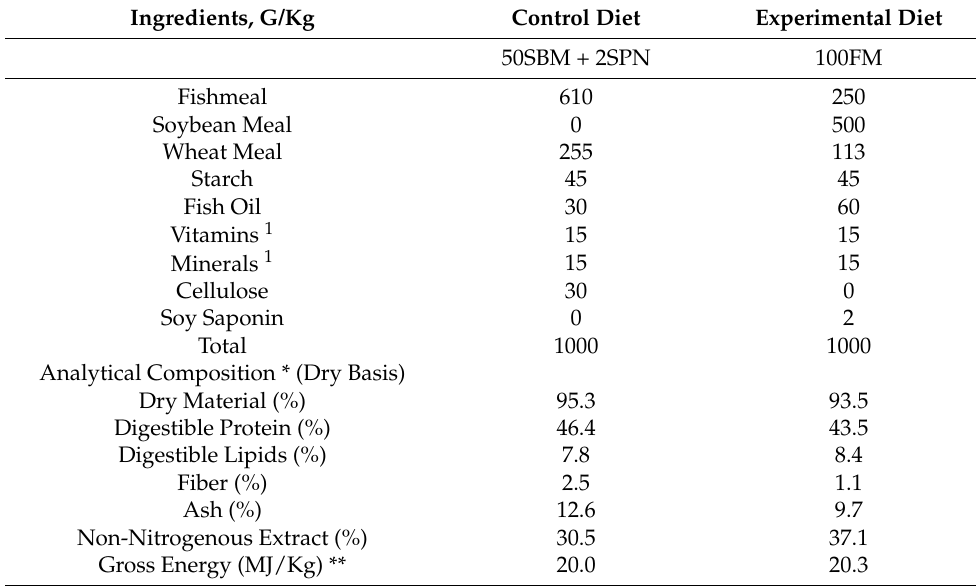
Table 1. Ingredients and nutrient composition of control and experimental